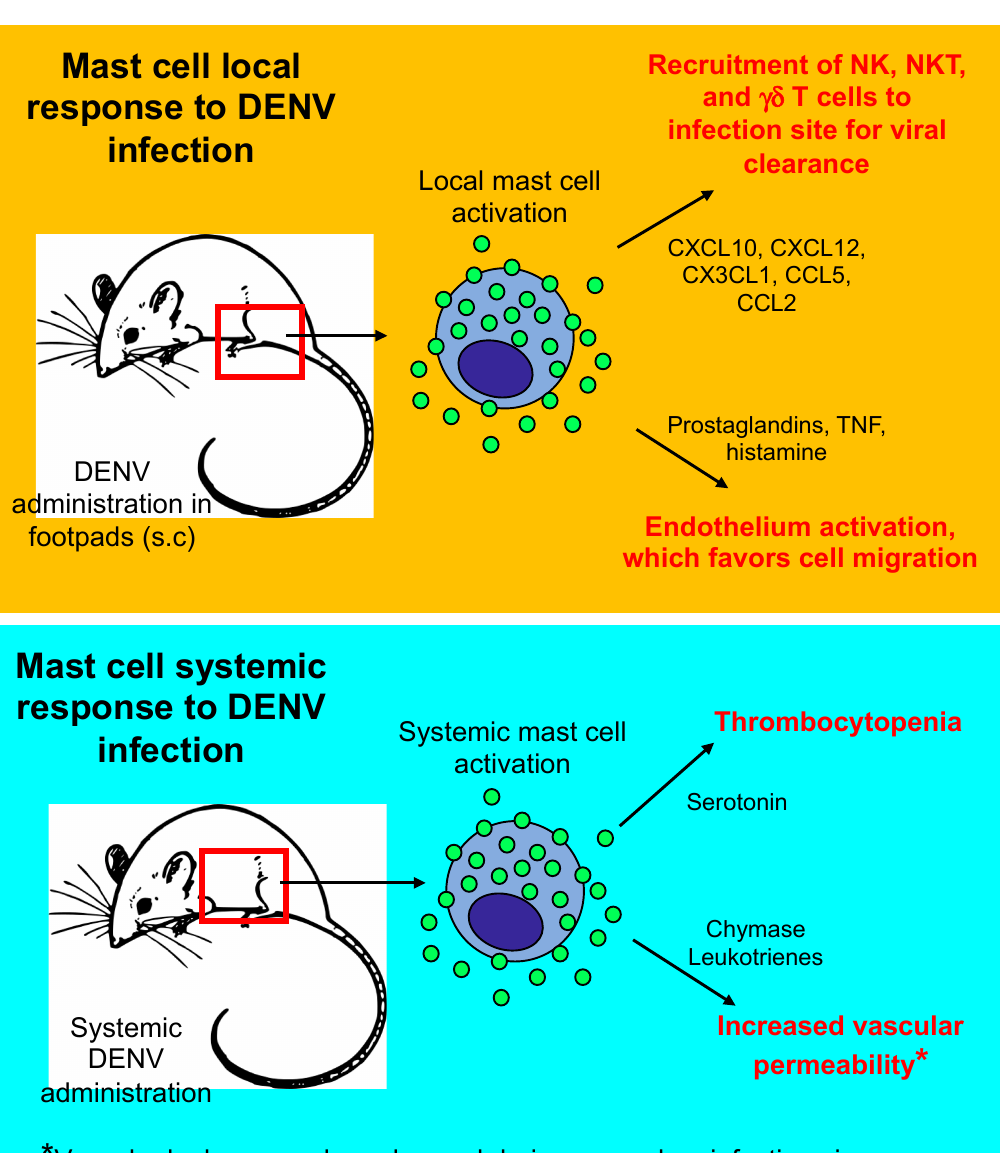
Figure 1. Mast cell response to local and systemic dengue virus infection. DENV, dengue virus; TNF, tumor necrosis factor; Fc γ R, Fc gamma receptor; NK, natural killer cells; NKT, natural killer T cells; γδ T cells, gamma delta T cells; s.c., subcutaneous; CXCL10, (C-X-C motif) chemokine ligand 10; CXCL12, (C-X-C motif) chemokine ligand 12; CX3CL1, (C-X3-C motif) chemokine ligand 1; CCL5,